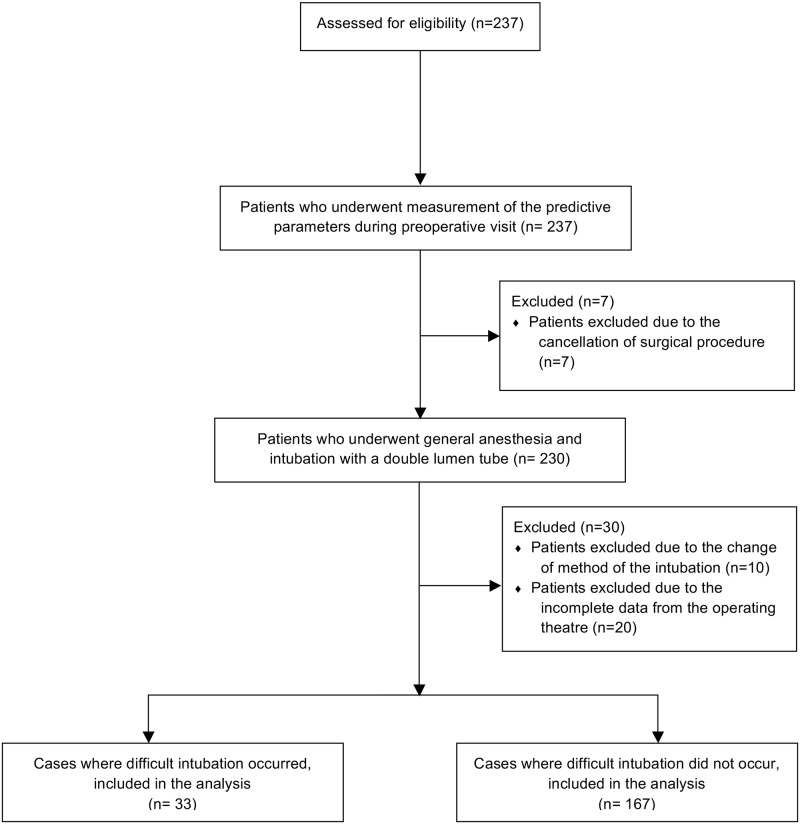
CONSORT flow chart.